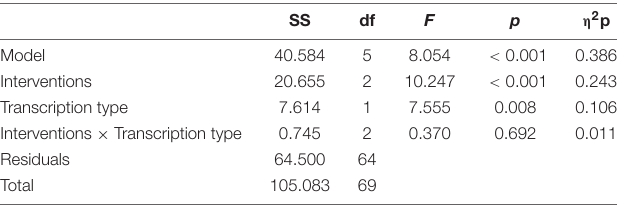
TABLE 3 | Moderation effect of transcription type (alphabetic vs non-alphabetic) in the direct influence of interventions on bilingual children’s notational